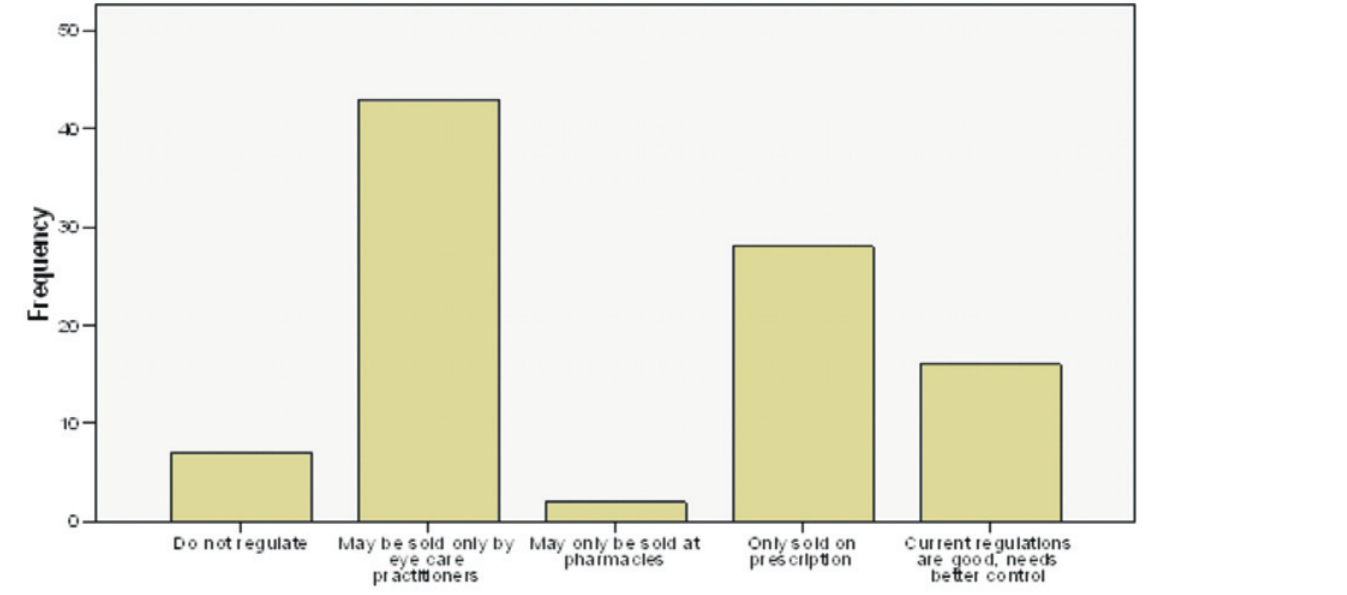
Figure 2: Opinion regarding the regulation of ready-made readers